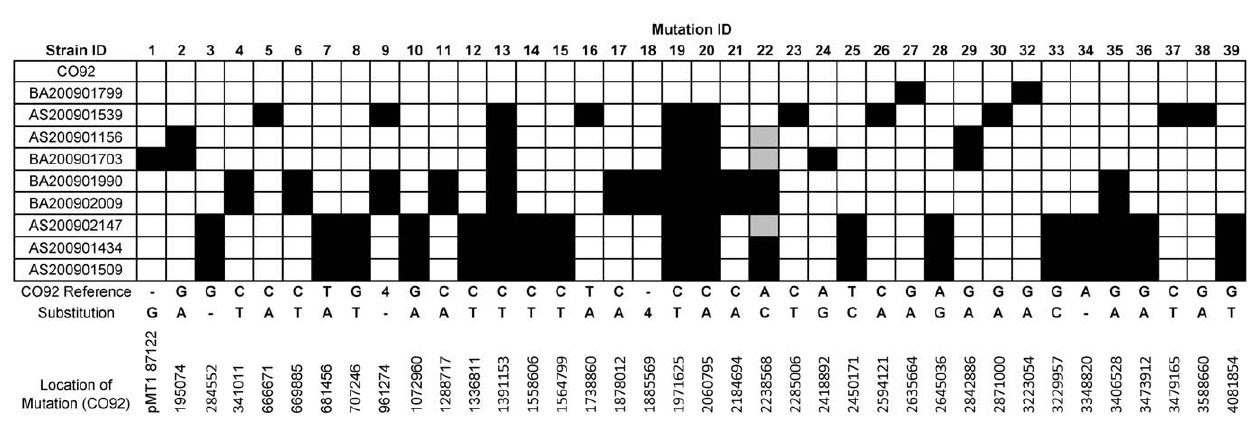
Figure 2. Genetic Diversity of the 2009 Plague Isolates. Distribution of mutations through the 2009 isolates. Mutations relative to the parent strain (CO92) are indicated by black squares. Grey squares indicate that the mutation was not called automatically but was evident by manual inspection of the assembly. Mutation 31 from Table 2 is not shown nor incorporated into the phylogeny as it is an expansion of a 10 bp repeating sequence.